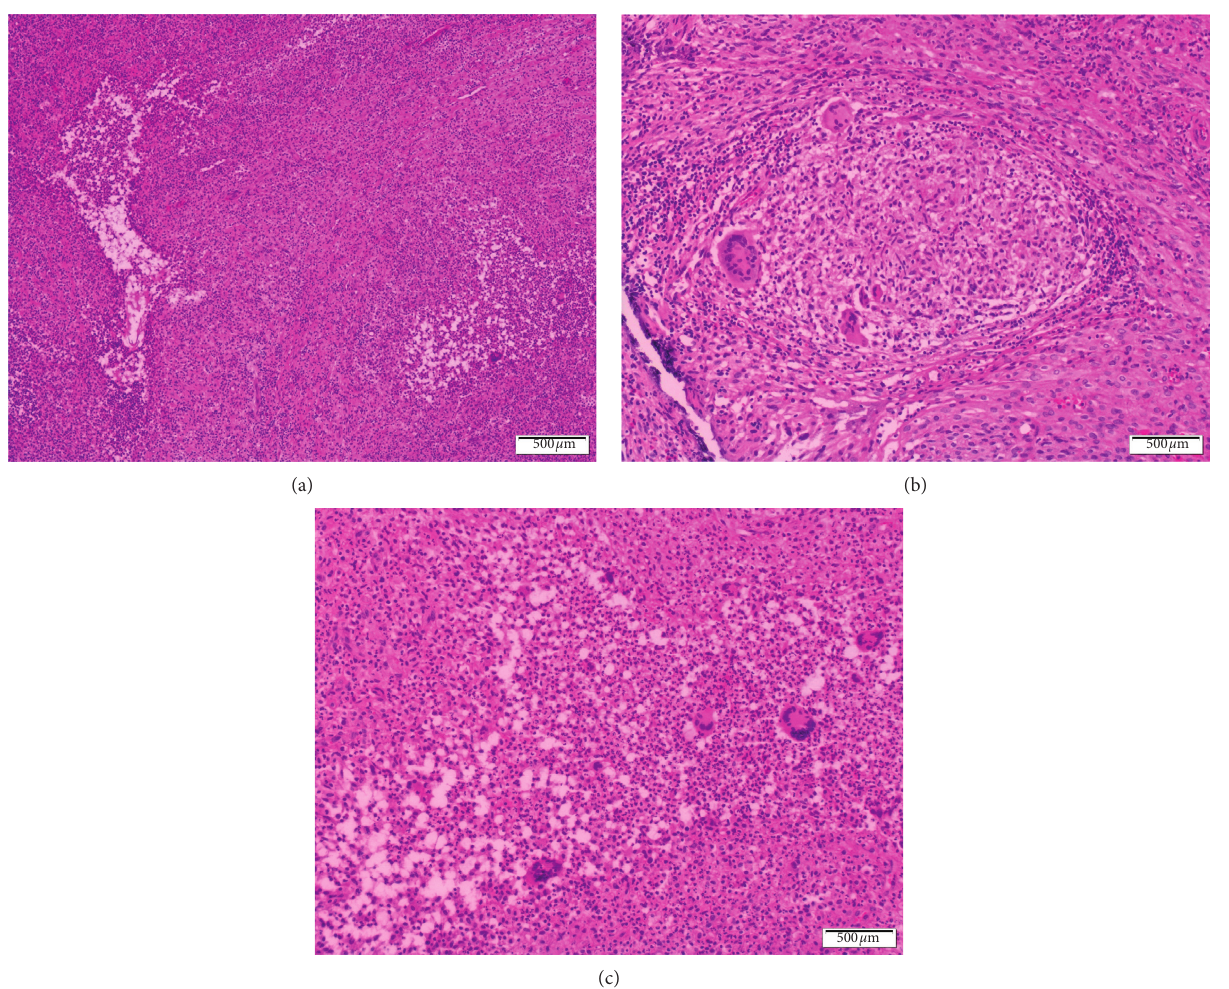
Figure 1: Histopathological findings in the resected ovarian mass. (a) Low-power view showing diffuse mixed inflammatory infiltrate of the ovarian stroma with the formation of a microabscess “on the left side of the figure” and a suppurative granuloma “on the right side of the figure” (H&E, × 40). (b) A nonnecrotizing granuloma composed of epithelioid histiocytes, few multinucleated giant cells, and a thin rim of lymphocytes (H&E, × 100). (c) Another epithelioid granuloma with central suppurative inflammation composed of numerous neutrophils (H&E, ×